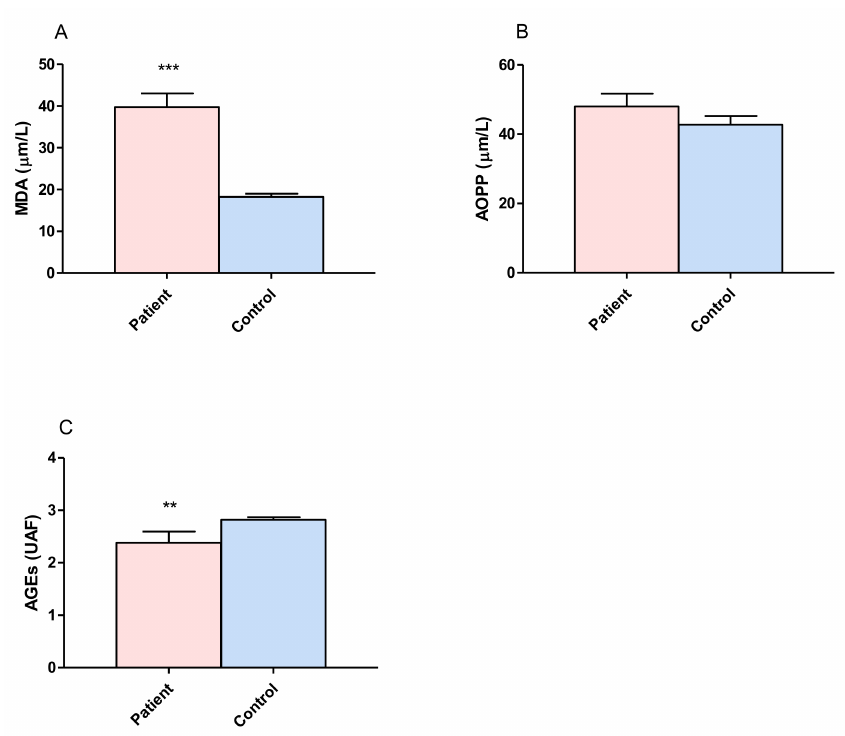
Figure 1. Comparison of concentrations of malondialdehyde (MDA), advanced oxidation protein products (AOPP) and advanced glycation end products (AGEs) between patients with drug resistant partial complex seizure and controls. ( A ) MDA serum concentration. ( B ) AOPP serum concentration. ( C ) AGEs serum concentration. The bars represent the means ± the standard errors of the mean. Unpaired t-Student test. ** p ≤ 0.004, *** p ≤ 0.0001.